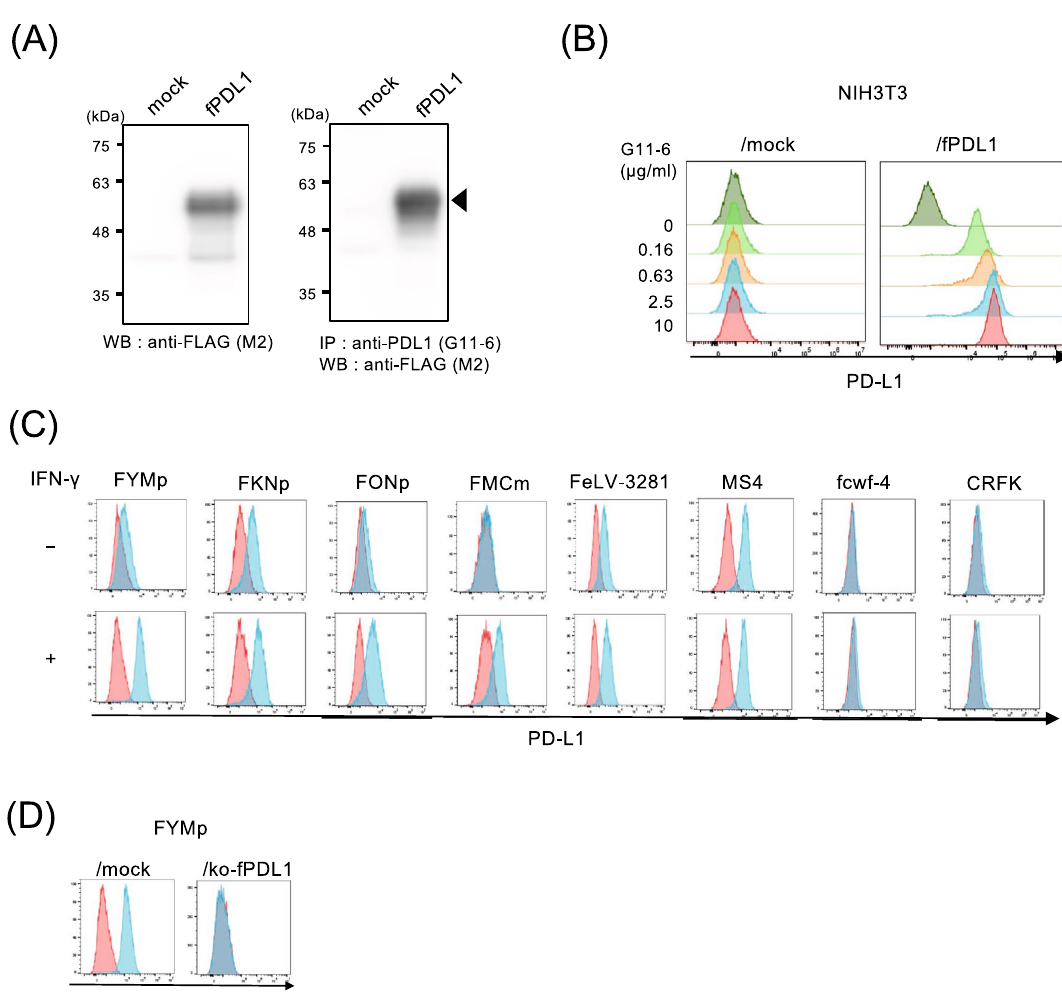
Figure 2. Cross-reactivity of anti-canine PD-L1 mAb with feline PD-L1 and analysis of PD-L1 expression in feline cell lines. ( A ) Cell lysates from NIH3T3 or mock and NIH3T3/fPDL1 or NIH3T3/fPDL1 were extracted and used for western blotting and immunoprecipitation. Western blotting was performed using anti-FLAG antibody (M2). For immunoprecipitation, cell lysates were immunoprecipitated with anti-canine PDL1 mAb (G11-6), and western blotting was performed using an anti-FLAG antibody (M2). Full images of western blotting at several different exposure time are shown in Supplementary Figure for Fig. 2A. ( B ) NIH3T3 or mock and NIH3T3/fPDL1 or NIH3T3/fPDL1 were stained with serially titrated mAb for anti-PD-L1 (G11-6) followed by staining with a secondary anti-rat IgG-DyLight649 antibody. ( C ) Flow cytometric analysis of feline PD-L1 expression in feline cell lines. Cell lines were treated with or without IFN-γ for 24 h. Cell lines were collected and stained with an isotype control or G11-6, followed by a secondary antibody. The red and blue histograms indicate the isotype control and G11-6 staining, respectively. ( D ) Flow cytometric analysis of feline PD-L1 expression in feline PD-L1-knocked out cell line, FYMp/ko-fPDL1 cells. Cell lines were treated with or without IFN-γ for 24 h. FYMp and FYMp/ko-fPDL1 cells were collected and stained with an isotype control or G11-6, followed by a secondary ing of fPDL1-hIg in an antibody dose-dependent manner (Fig. 3C left panel). Similarly, anti-feline PD-L1 mAb, clone G11-6, inhibited the binding of fPD1-hIg to NIH3T3/fPDL1 (Fig. 3C right panel). Feline PD‑1 and PD‑L1 expressions in stimulated lymphocytes. To investigate the expression of PD-1 and PD-L1 in feline immune cells, flow cytometry using anti-fPD-1 and fPD-L1 mAbs was performed on unstimulated and concanavalin A (Con A)-stimulated feline peripheral blood lymphocytes (PBLs). PD-1 and PD-L1 expression was not detected in unstimulated PBMC, but mitogenic stimulation with Con A for 48 h induced PD-1 and PD-L1 expression (Fig. 4). Production of IFN‑γ stimulated by inhibition of PD‑1/PD‑L1 with mAbs. To examine the effect of inhibiting fPD-1/PD-L1 binding in lymphocytes by mAbs, we measured the levels of IFN-γ released from the stimulated PBLs into the culture supernatant. As shown in Fig. 5A, PBLs collected from seven healthy cats were